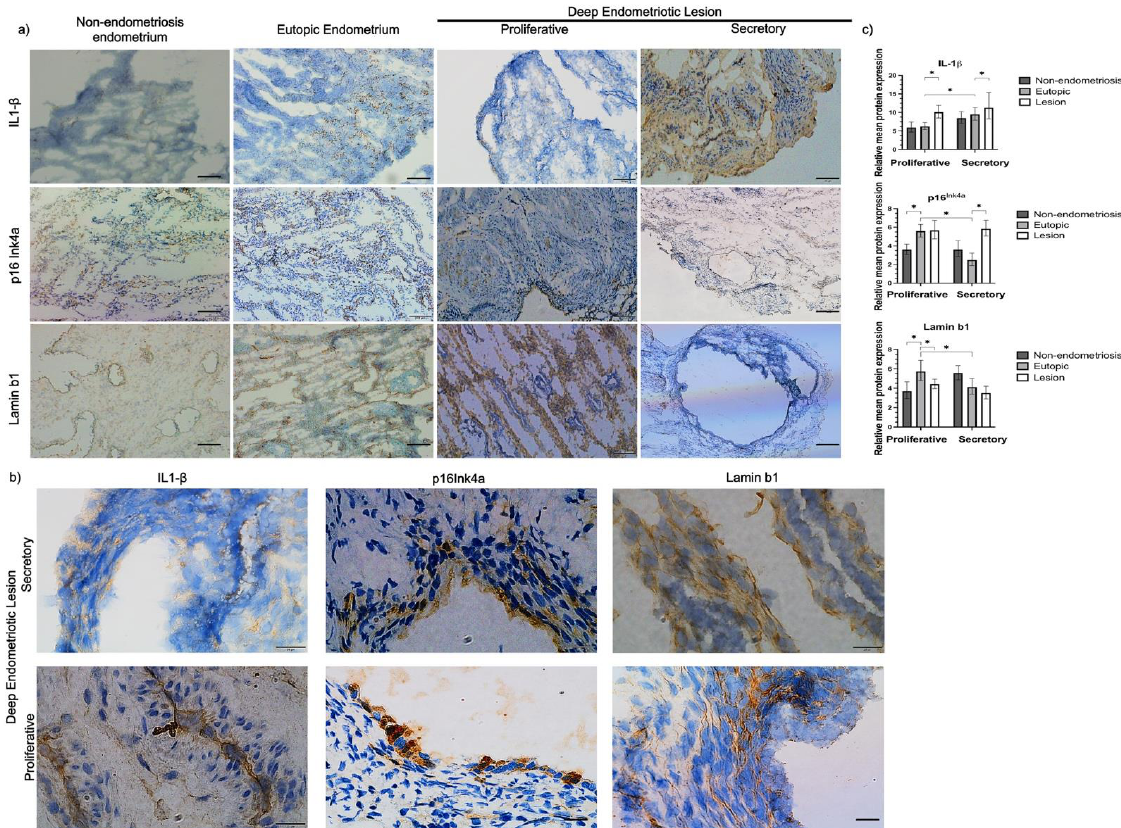
Figure 1. ( a ) Representative images of p16 Ink4a , lamin b1, and IL- 1β staining on endometriosis tissues and non-endometriosis. The brown color represents the areas stained by the anti-p16ink4a, anti-lamin b1, and IL- 1β antibodies ; the hematoxylin (blue color) marks the cell nuclei; and the white spaces represent spaces with no cells. i Ovary, positive reaction control; ii ovary, negative reaction control; iii non-endometriosis endometrium; iv eutopic endometrium; v endometriosis lesions. Pictures were acquired at 20X magnification. Scale: 100 µm. ( b ) Representative images of p16 Ink4a and lamin b1 staining in deep endometriosis lesion tissues. The brown color represents the areas stained by the p16 Ink4a , lamin b1, and IL- 1β antibodies; the blue color (DAPI—4′,6 -diamidino-2-phenylin- dole) marks the cell nuclei. Images suggest the presence of stromal cells (red circle) and epithelial cells (yellow star) in deep endometriosis lesions. I Lamin b1-stained deep endometriosis lesions; ii p16 Ink4a -stained deep endometriosis lesions; iii IL- 1β -stained deep endometriosis lesions. Pictures were acquired at 20X and 100X magnifications. Scale: 10 µm. ( c ) Protein expression of p16 Ink4a , lamin b1, and IL- 1β, compare d between control, eutopic endometrium, and lesion. The percentage repre- sents the total area marked by the tissue in each image. The average of each of the 16 images for each tissue was calculated, and the value of this average was used to calculate the difference be- tween the groups. * p < 0.05. Results are presented as mean and confidence interval estimated from generalized linear models of the gamma family.